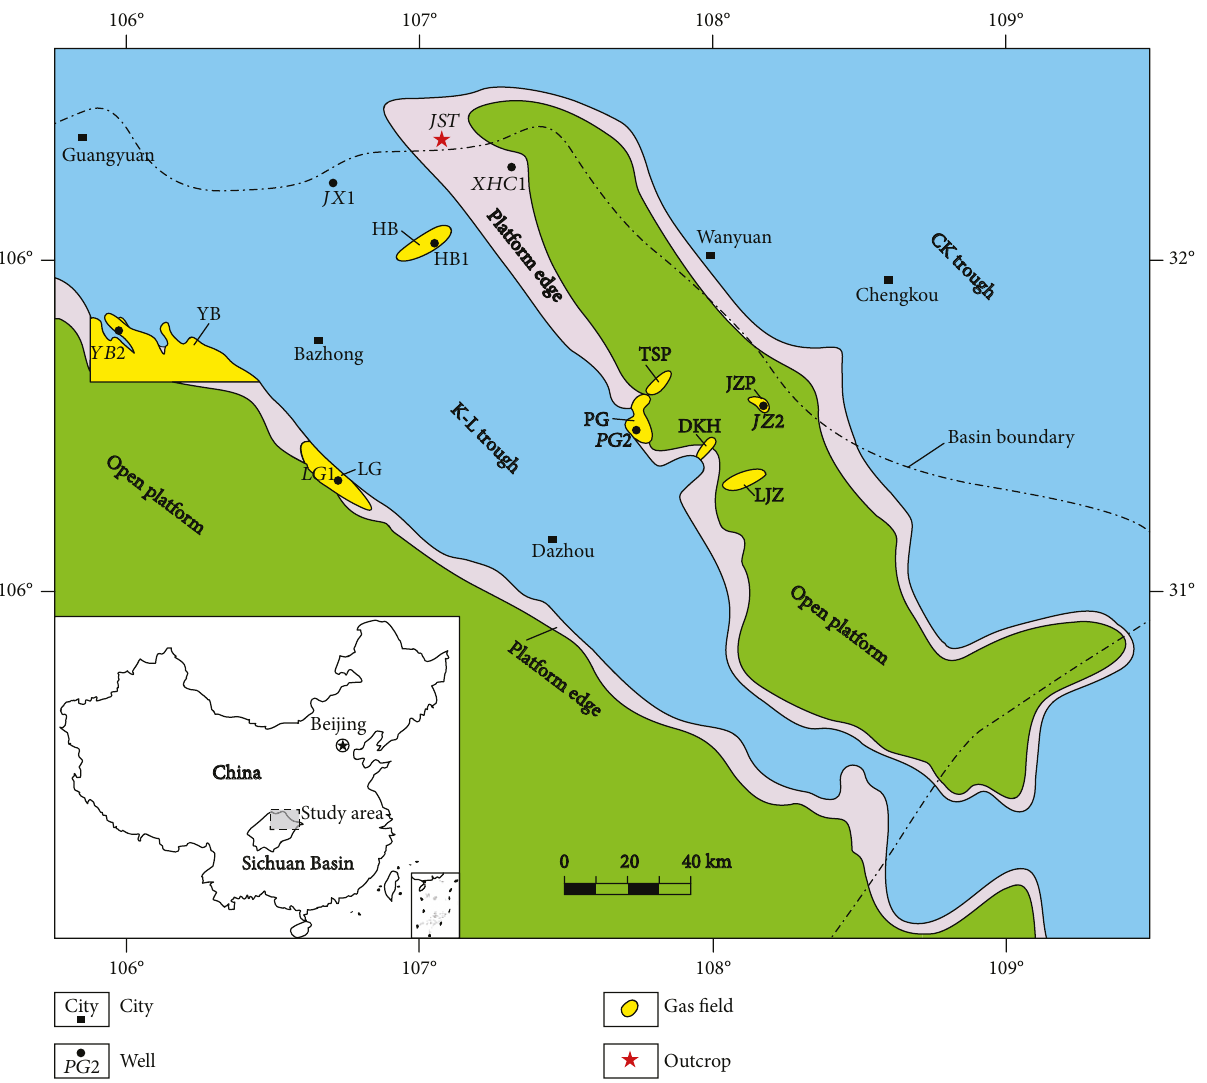
Figure 1: Main gas fi elds and sedimentary facies of the upper part of the Changxing Formation (P Basin (modi fi ed from [23, 24]). YB=Yuanba; LG=Longgang; HB =Heba; PG=Puguang; TSP=Tieshanpo; LJZ=Luojiazhai; DKH=Dukouhe; JZP =Jinzhuping; JST=Jiaoshutang; K-L=Kaijiang-Liangping; CK